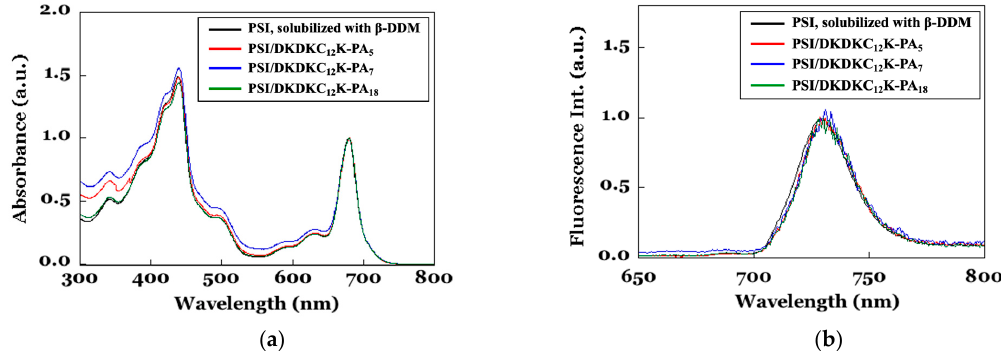
Figure 4. Absorption and fluorescence spectra of PSI, solubilized with 0.1 wt% β‐ DDM, or conjugated with DKDKC 12 K ‐ PA n ( n = 5, 7, 18). ( a ) Absorption spectra of PSI, solubilized with 0.1 wt% β‐ DDM (black), DKDKC 12 K ‐ PA 5 (red), DKDKC 12 K ‐ PA 7 (blue), and DKDKC 12 K ‐ PA 18 (green). ( b ) Florescence spectra of PSI, solubilized with 0.1 wt% β‐ DDM (black), DKDKC 12 K ‐ PA 5 (red), DKDKC 12 K ‐ PA 7 (blue), and DKDKC 12 K ‐ PA 18 (green).